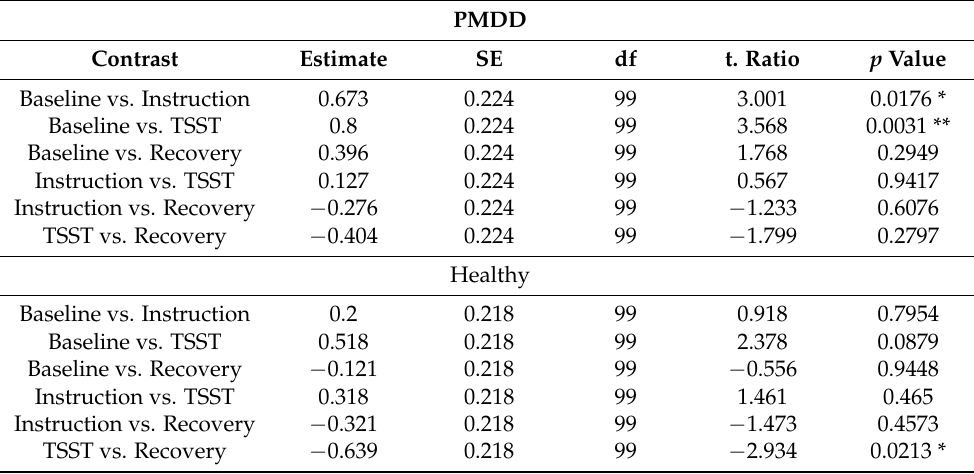
Table 2. HRV Changes Across TSST Timepoints According to